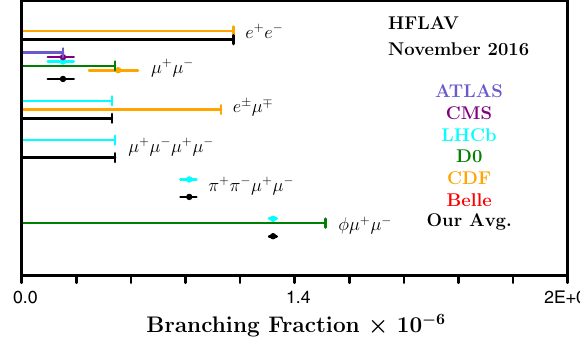
Fig. 181 Branching fractions of charmless leptonic B 0 s